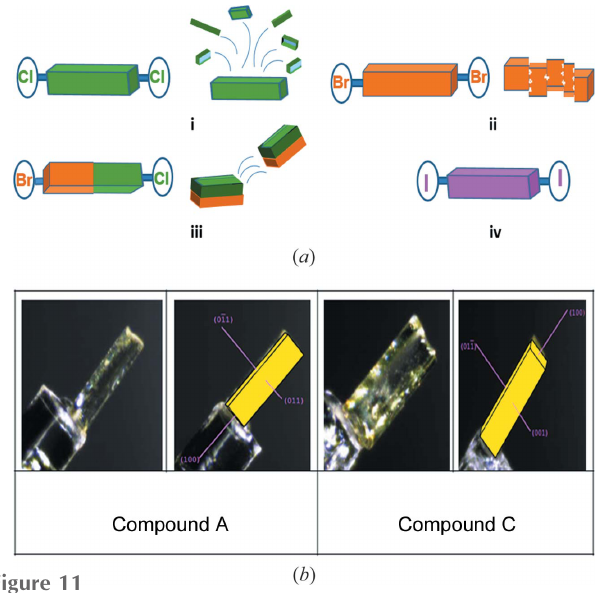
Figure 11 ( a ) Thermosalient effects of crystals, such as (i) jumping/explosion, (ii) cracking and (iii) rapid breaking of a crystal into two pieces during the phase transition. (iv) The iodine derivative crystal is intact upon heating. ( b ) Morphology and faces of Form I crystals of Compounds-A and C.